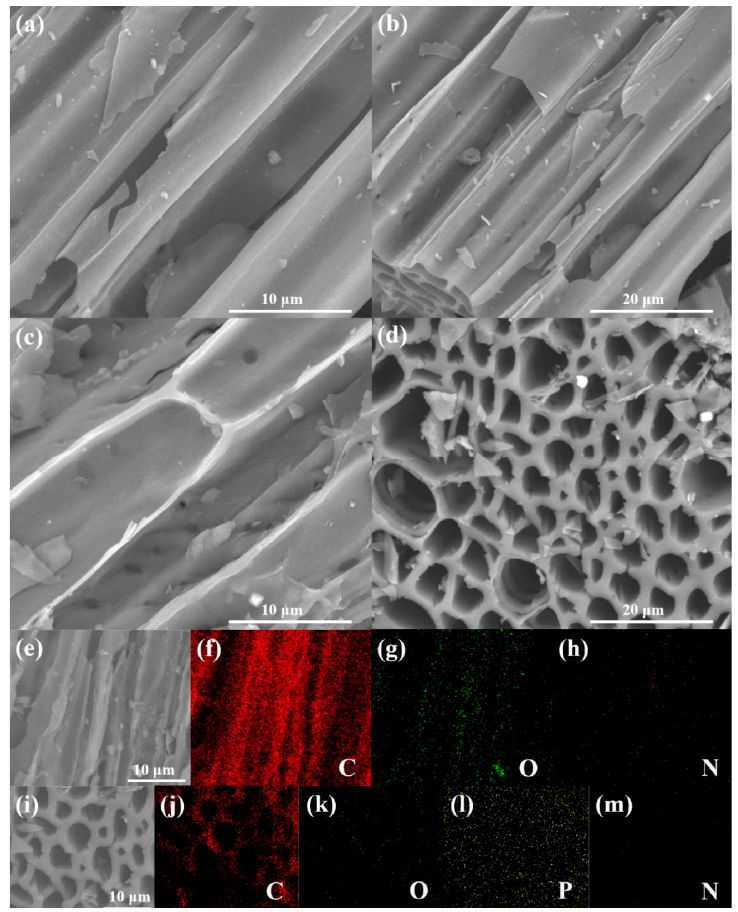
Figure 2. The SEM image of SPC ( a , b ), PA − SPC ( c , d ), EDS elemental mapping images of SPC ( e − h ) and PA − SPC ( i − m ).